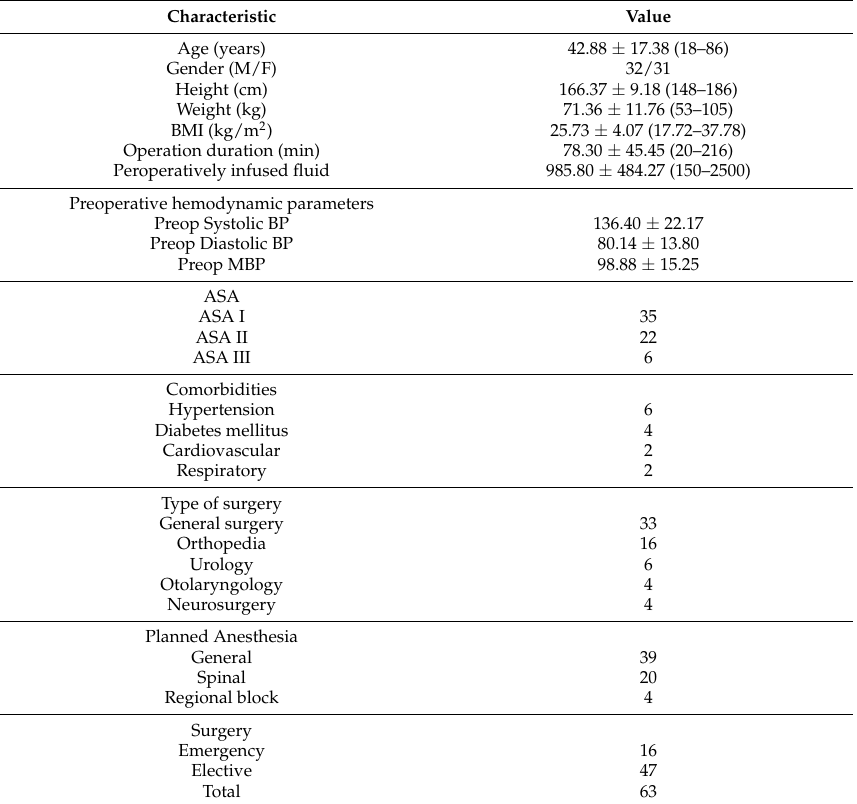
Table 1. Demographic data of the